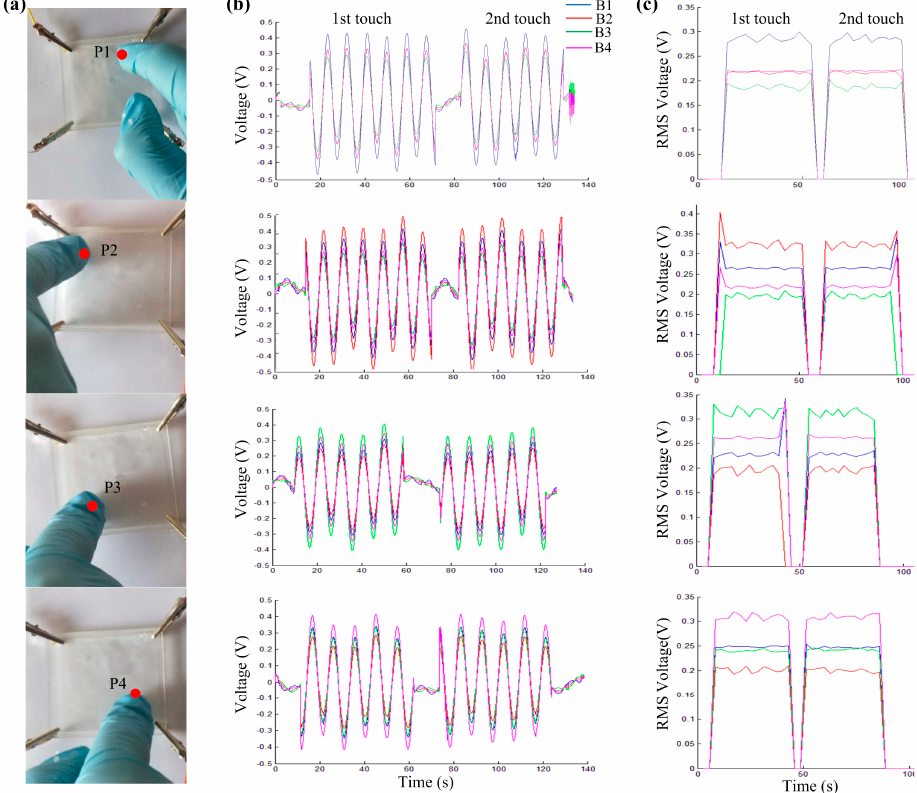
Figure 7. Responses of touches on a gel panel. ( a ) Photo images of the touch panel and four touch points. Round dots represent touch points, and P1–P4 represent touch points 1–4. ( b ) The output voltage curves of each section for two repeated touches on each touch point with a short interval between touches. ( c ) Plots of RMS values of the output voltages.